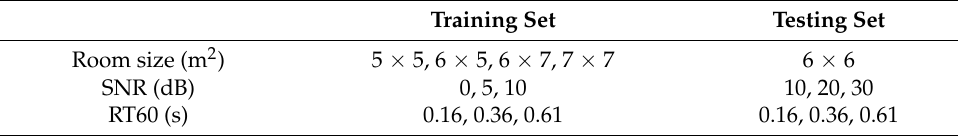
Table 5. A multiple acoustic environment